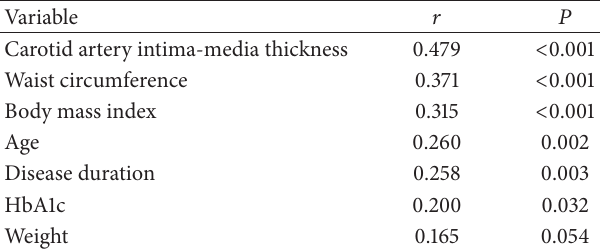
Table 2: The univariate correlations of the epicardial fat thickness.